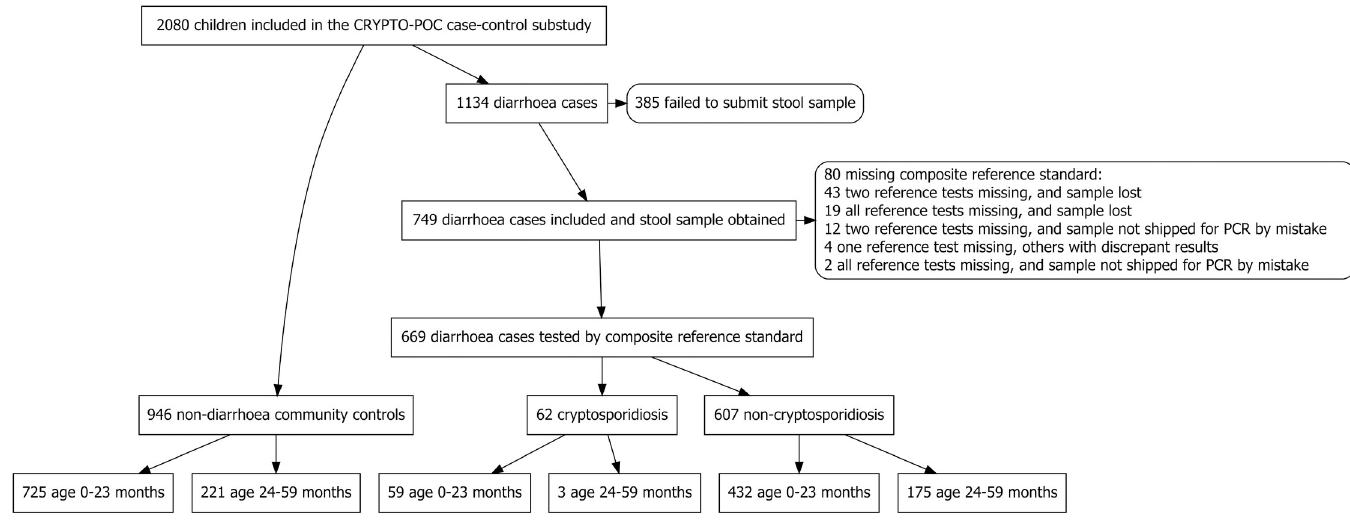
Fig 2. Study flowchart. For details on screening and eligibility, see flow diagram in previous publication [29]).